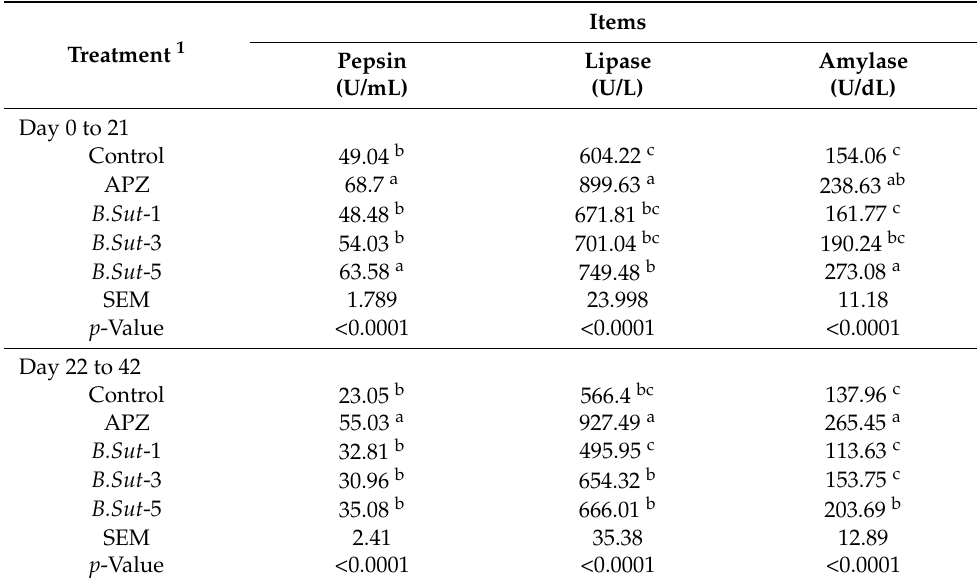
Table 5. Effect of the addition of Bacillus subtilis into broiler diets on digestive enzyme activities of broiler chickens at 21st and 42nd days